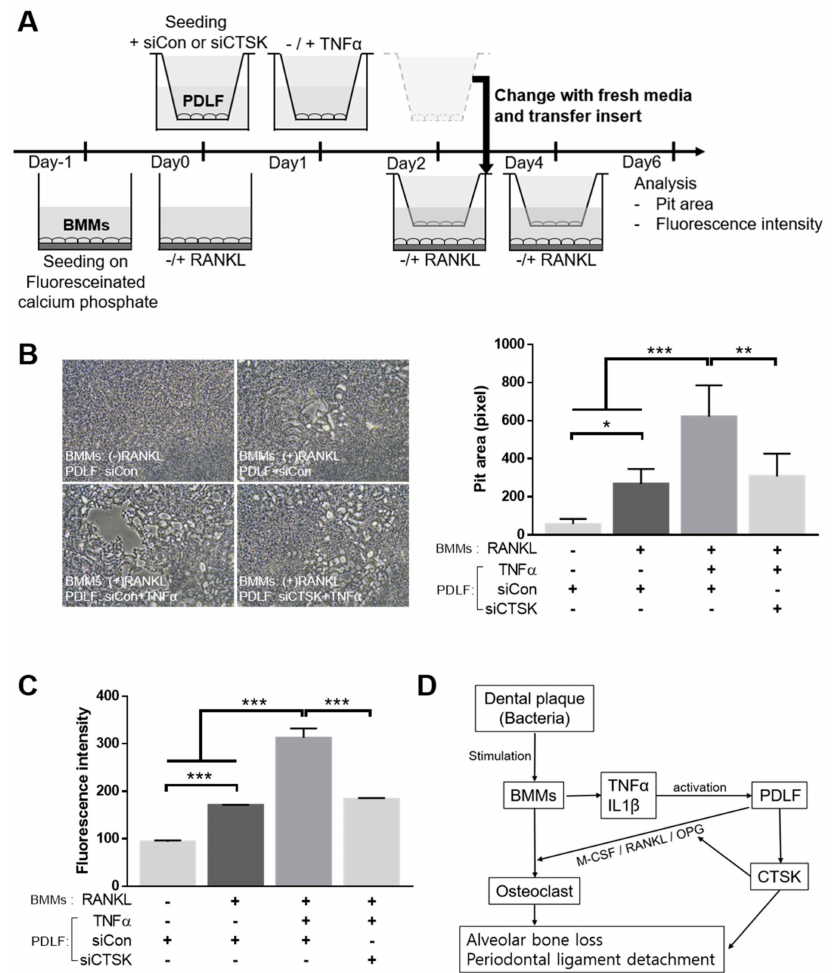
Figure 6. The role of CTSK in the TNF α -stimulated paracrine regulation of bone resorption. ( A ) A schematic diagram of the experimental procedure. PDLFs transfected with either siControl or siCTSK were seeded on the upper chamber of the transwell. Upon 24-h treatment with TNF α , the PDLF-seeded upper chamber was transferred to the BMM-seeded lower chamber coated with fluorescein-labeled calcium phosphate. Osteoclastogenesis was induced with 100 ng/mL of RANKL every other day and analyzed on day 6. ( B ) Representative microscopic images (left) and quantitative analysis (right) of the pit area. ( C ) The quantitative analysis of the fluorescence intensity in the conditioned medium. ( D ) A schematic diagram showing the novel suggested regulatory mechanism of CTSK in the PD microenvironment. CTSK expression is stimulated by inflammatory cytokines in osteoclastogenesis-supporting cells. CTSK could contribute to the deterioration of PD either directly via involvement of alveolar bone loss and periodontal ligament detachment or indirectly via modulation of the osteoclastogenesis-regulating factor. Data represent the mean ± S.E.M. * p < 0.05, ** p < 0.01, and *** p < 0.001 by one-way